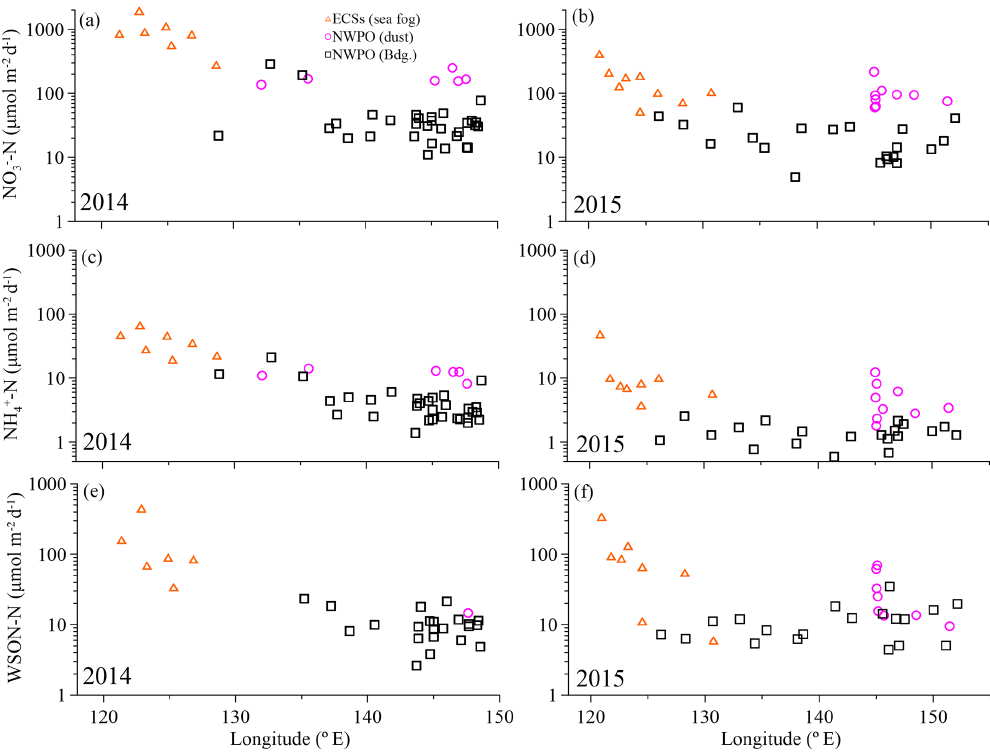
Figure 8. Dry deposition of aerosol NO − NWPO (pink open circles for dust aerosol and black open squares for background aerosol) along longitude during the 2014 and 2015 cruise,